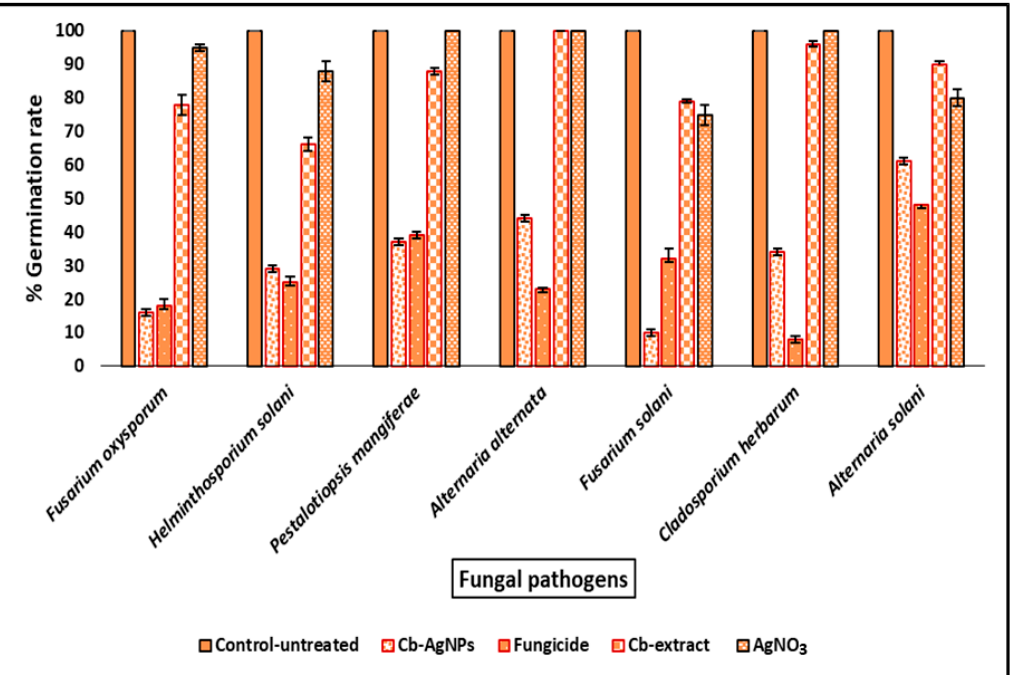
Figure 7. Percentage spore germination of fungal test pathogens treated with synthesized cranberry silver nanoparticles at 64 µg/mL − 1 . silver nanoparticles at 64 µ g/mL − 1